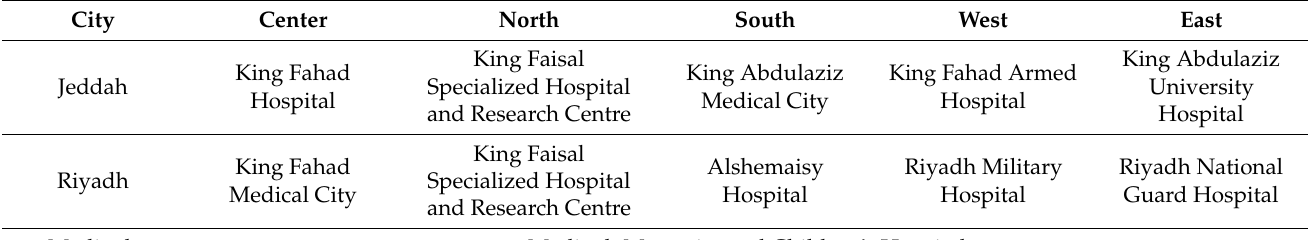
Table 1. List of tertiary medical centers included in the study according to their city and regional